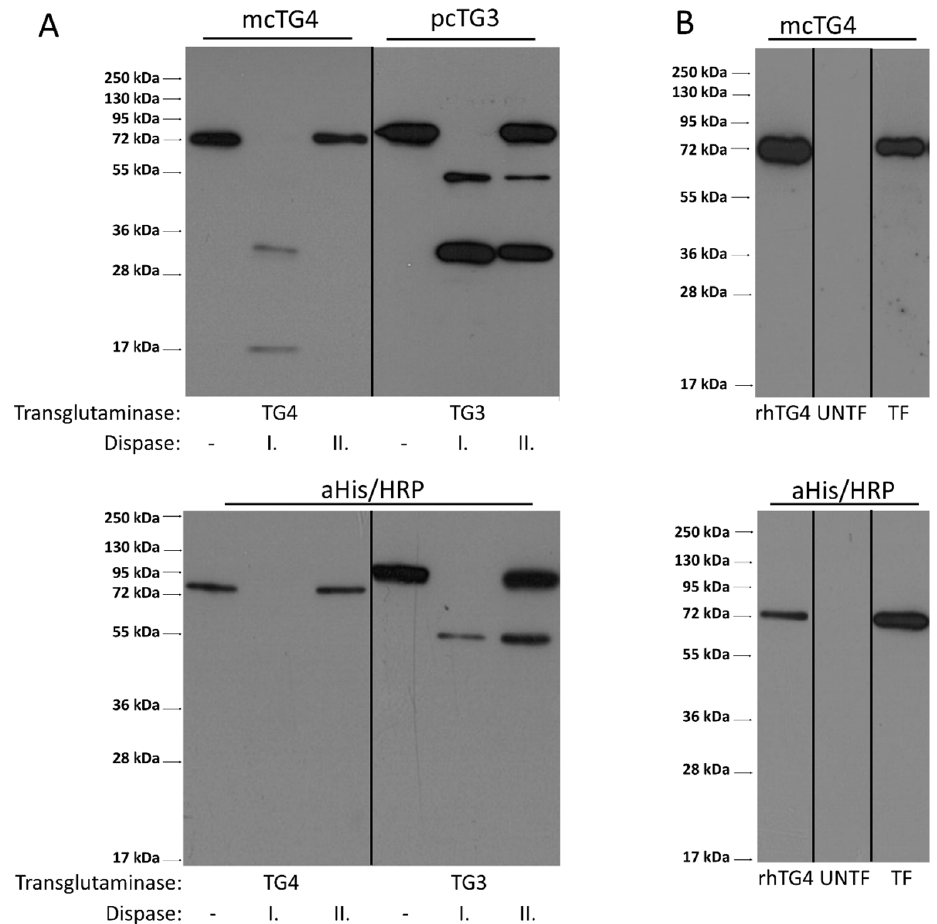
Figure 5. Limited proteolysis of hTG4 protein does not occur upon dispase digestion or its ex- pression in AD-293 cells. ( A ) The effects of dispase I and II on hTG4 protein were examined by Western blot analysis. Recombinant hTG3 or hTG4 were incubated for 60 min at 37°C, in the presence of 5 mM Ca 2+ alone or with the same amount of either dispase I or dispase II. From each reaction, 0.3 µg transglutaminase protein was tested by Western blot using monoclonal anti-TG4 (mcTG4) or polyclonal anti-TG3 (pcTG3) antibodies (upper part) and anti-polyHis/HRP antibody (aHis/HRP). Representative gel pictures of two independent experiments are presented. ( B ) AD-293 cells express exogenous hTG4 in full-length form without significant limited proteolysis revealed by Western blot. 0.3 µg recombinant hTG4 (rhTG4) was used as positive control while 10 µg protein extract of untransfected (UNTF) and transfected AD-293 cells (TF) were examined. Representative picture from three independent experiments. The vertical lines on the blots are labelling the place of the membrane cuttings.